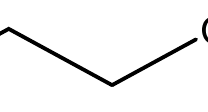
Figure 1. Chemical structure of β -aminopropionitrile (BAPN).